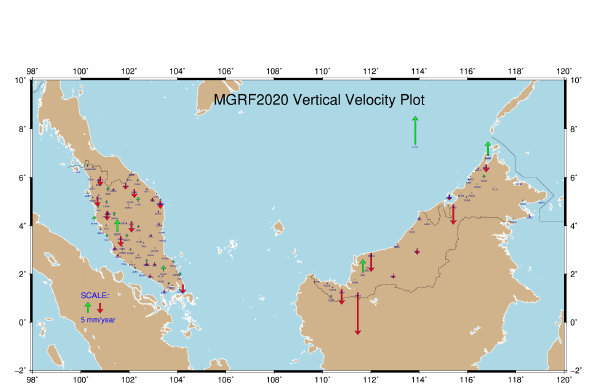
Fig. 5. Trajectory of Gua Musang station (GMUS), as an example of a station impacted by major earthquakes (2004 Mw 9.2 Sumatra- Andaman, 2007 Mw 7.9 Bengkulu and 2012 Mw 8.6 Indian Ocean earthquakes) angle-dependent errors tend to affect the vertical compo- nent more than the horizontal components (Mao et. al., 1999).